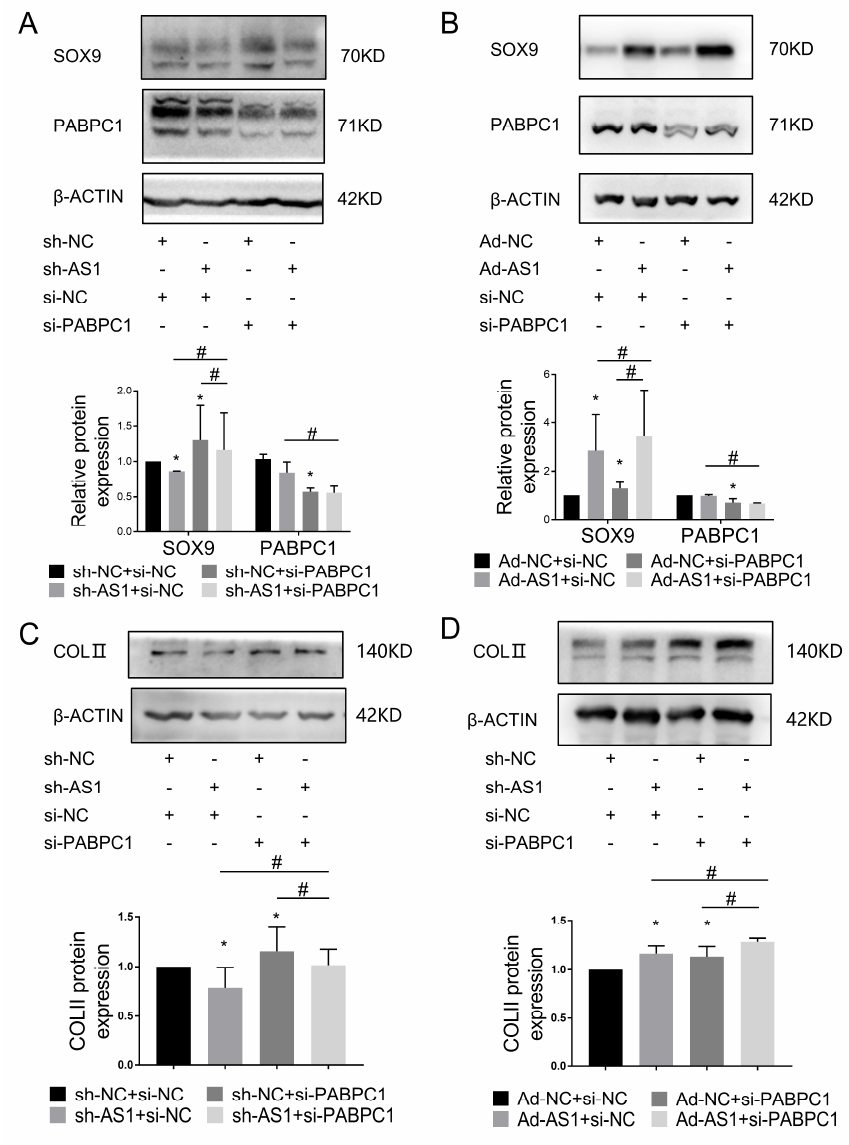
Figure 7. The binding of lncRNA WDR11-AS1 to PABPC1 stabilizes SOX9 expression and induces ECM synthesis in chondrocytes. ( A ) Western blot analysis showed SOX9 and PABPC1 levels in primary chondrocytes reducing WDR11-AS1 with siRNA-mediated PABPC1 knockdown. ( B ) Western blot analysis showed SOX9 and PABPC1 levels in primary chondrocytes overexpressing WDR11-AS1 with siRNA-mediated PABPC1 knockdown. ( C ) Western blot analysis showed COLII levels in primary chondrocytes reducing WDR11-AS1 with siRNA-mediated PABPC1 knockdown. ( D ) Western blot analysis showed COLII levels in primary chondrocytes overexpressing WDR11-AS1 with siRNA-mediated PABPC1 knockdown. * p < 0.05, the group vs. the sh-NC+si-NC group; # p < 0.05, the two groups under the horizontal line are compared. The measurement data are expressed as the mean ± standard deviation, and were analyzed by Mann-Whitney U test. The experiments were repeated three times.